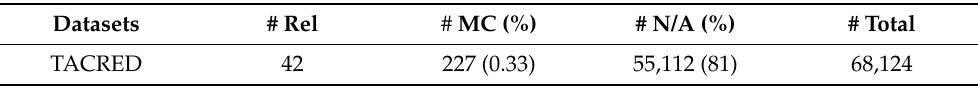
Table 3. Training dataset statistics. We list the number of relations (# Rel), MC instances (# MC), and no relation instances (# N/A) with the